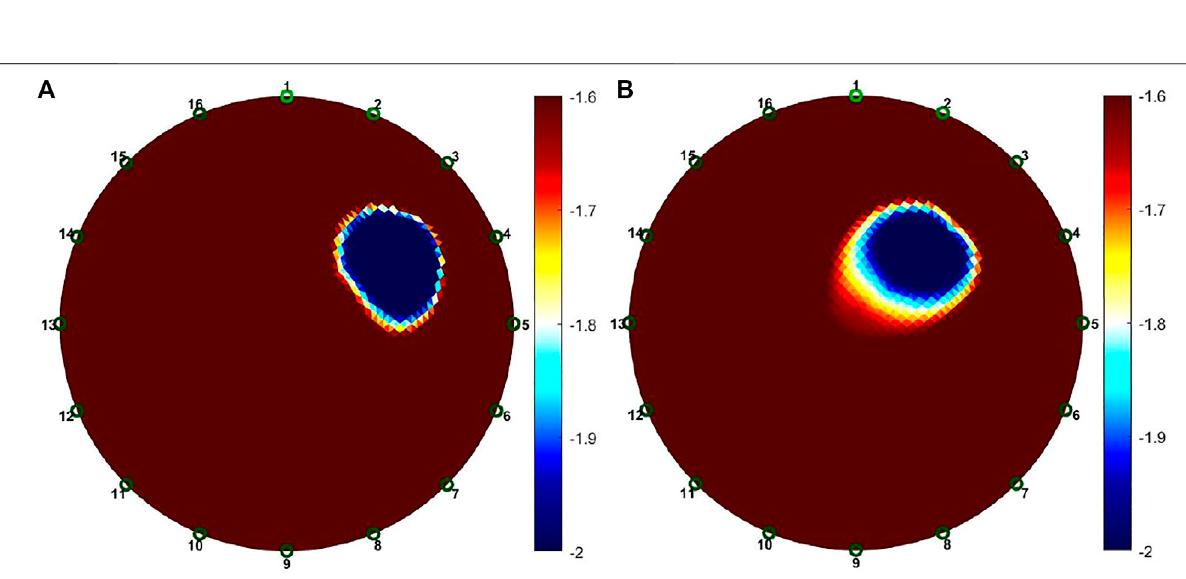
Frontiers in Electronics |